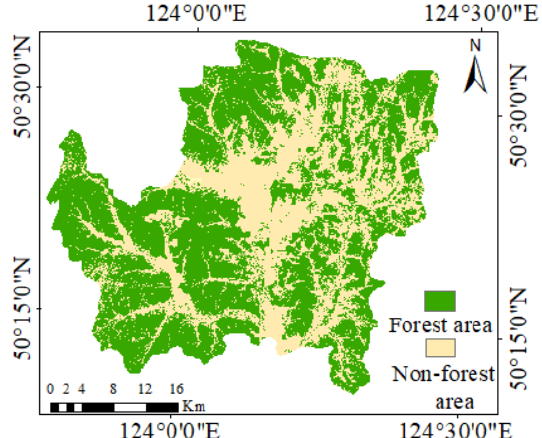
Figure 3. Classification map of forest area and non-forest area in Jiagedaqi area.